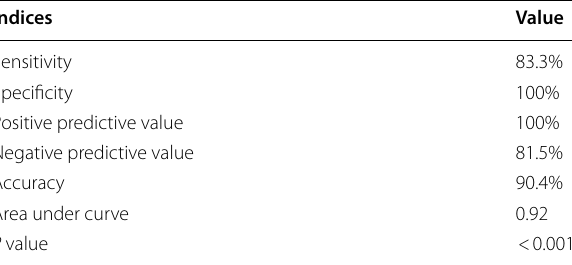
Table 2 Accuracy of FNAC in identifying malignant axillary lymph